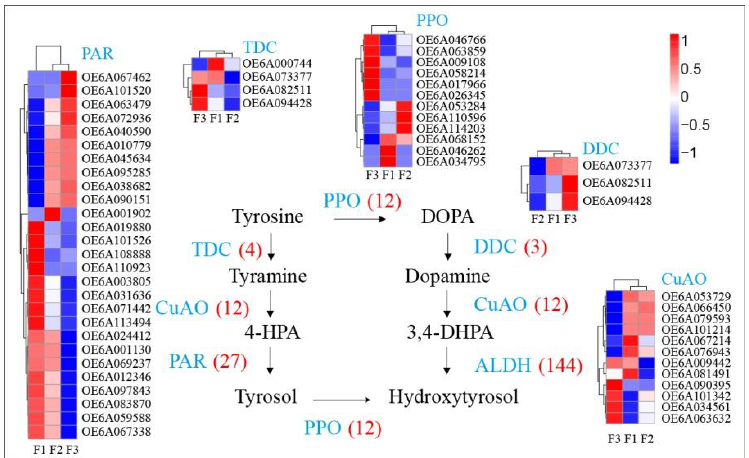
Figure 5. Expression of genes in hydroxytyrosol biosynthesis pathway and associated gene ex- pression levels within olive fruits at different maturity stages. levels within olive fruits at different maturity